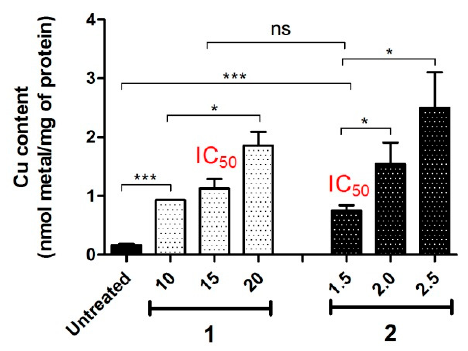
Figure 4. Intracellular Cu accumulation in A2780 cells. A2780 cells were treated with Cu(II)